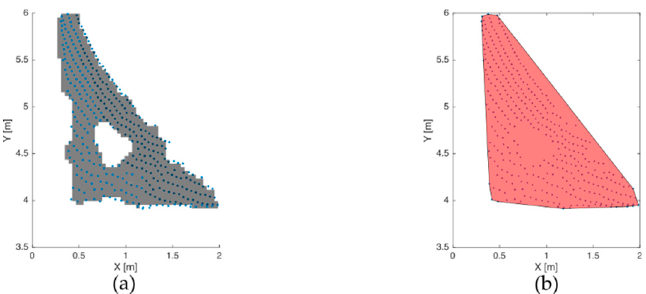
Figure 20. Planar surface area with a hole: ( a ) Level image; ( b ) Convex hull.